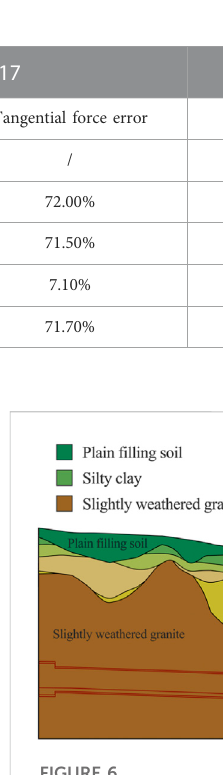
FIGURE 6 Geological pro fi le of the Shanwu tunnel section of the Qingdao